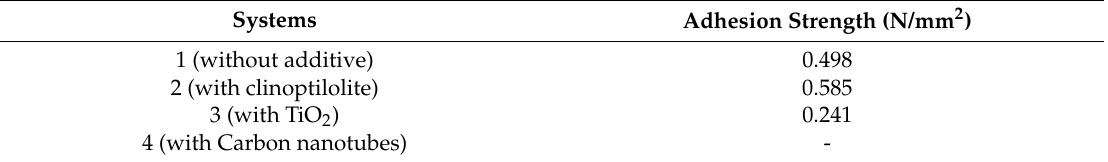
Table 4. Adhesion strength of mortars with variable composition containing one additive only.